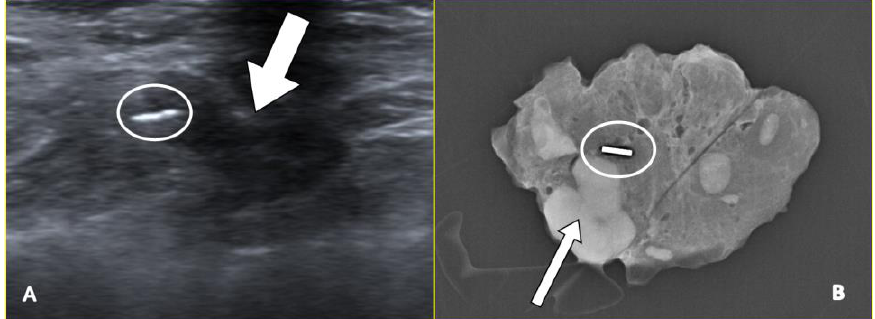
Figure 2. A 65-year-old patient with left breast cancer and ipsilateral left axillary node metastasis treated with neoadjuvant chemotherapy. The ultrasound image ( A ) shows a hyperechoic marker clip (circle) in the hypoechoic pathological axillary node (arrow). Subsequently, the post-surgical specimen radiogram ( B ) confirmed the presence of the markers (circle) adjacent to the pathological node (arrow).